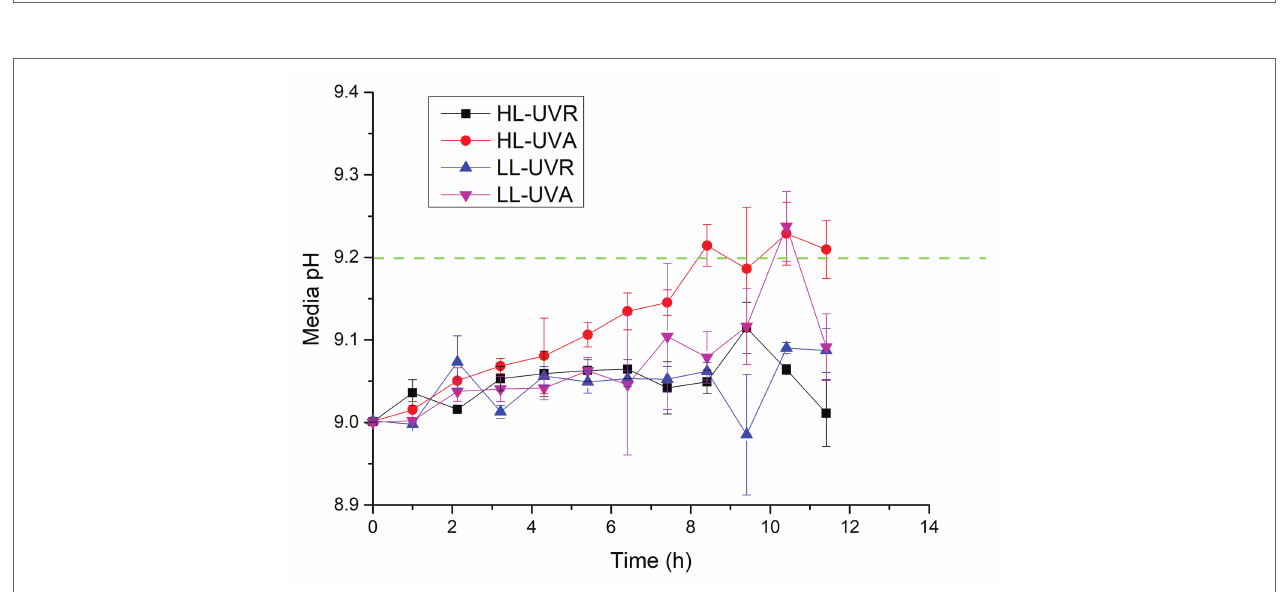
FIGURE 4 | Changes of pH in a closed system driven by photosynthesis of S. costatum when exposed to different UVR treatments. The initial pH was 9.00. The low (LL) and high (HL) light densities are 12.96 and 43.20 W m −2 for UVA, and 13.53 and 45.09 W m −2 for UVR (UVA + UVB), respectively. The error bars indicate the SDs ( n = 3). The dash line represents the pH compensation point above which indicates active HCO 3−